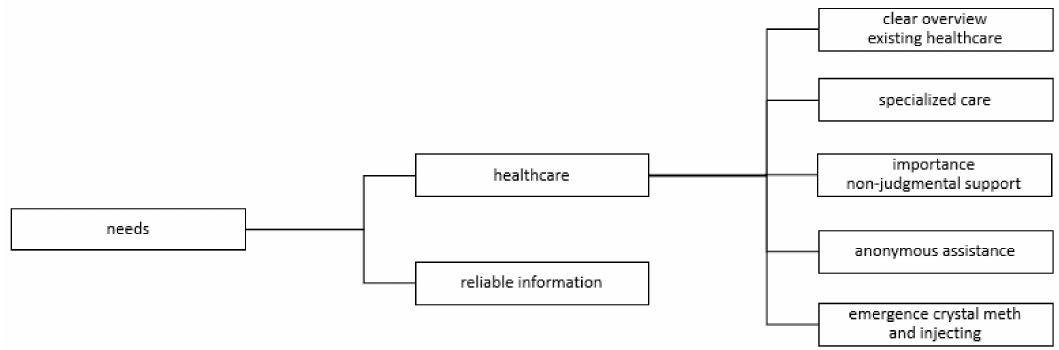
Figure 2. Schematic overview of information and care